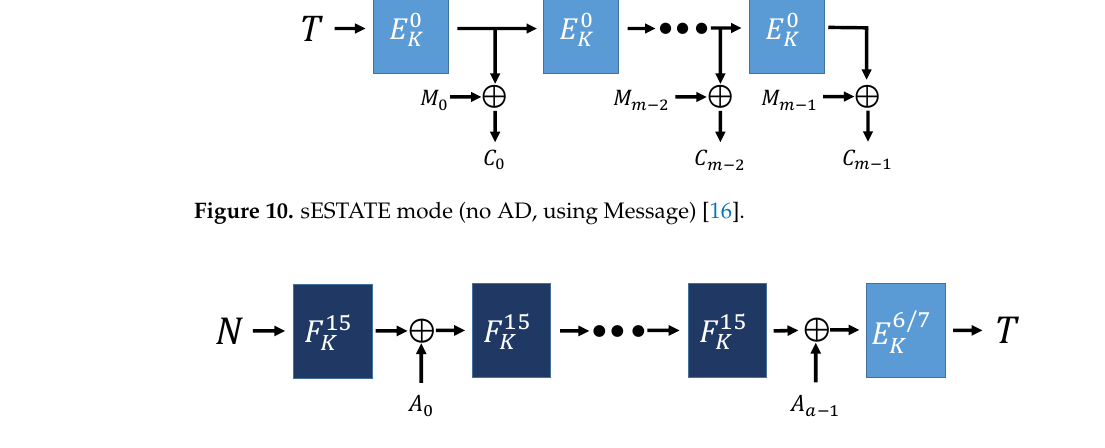
Figure 11. sESTATE mode (using AD, no Message)